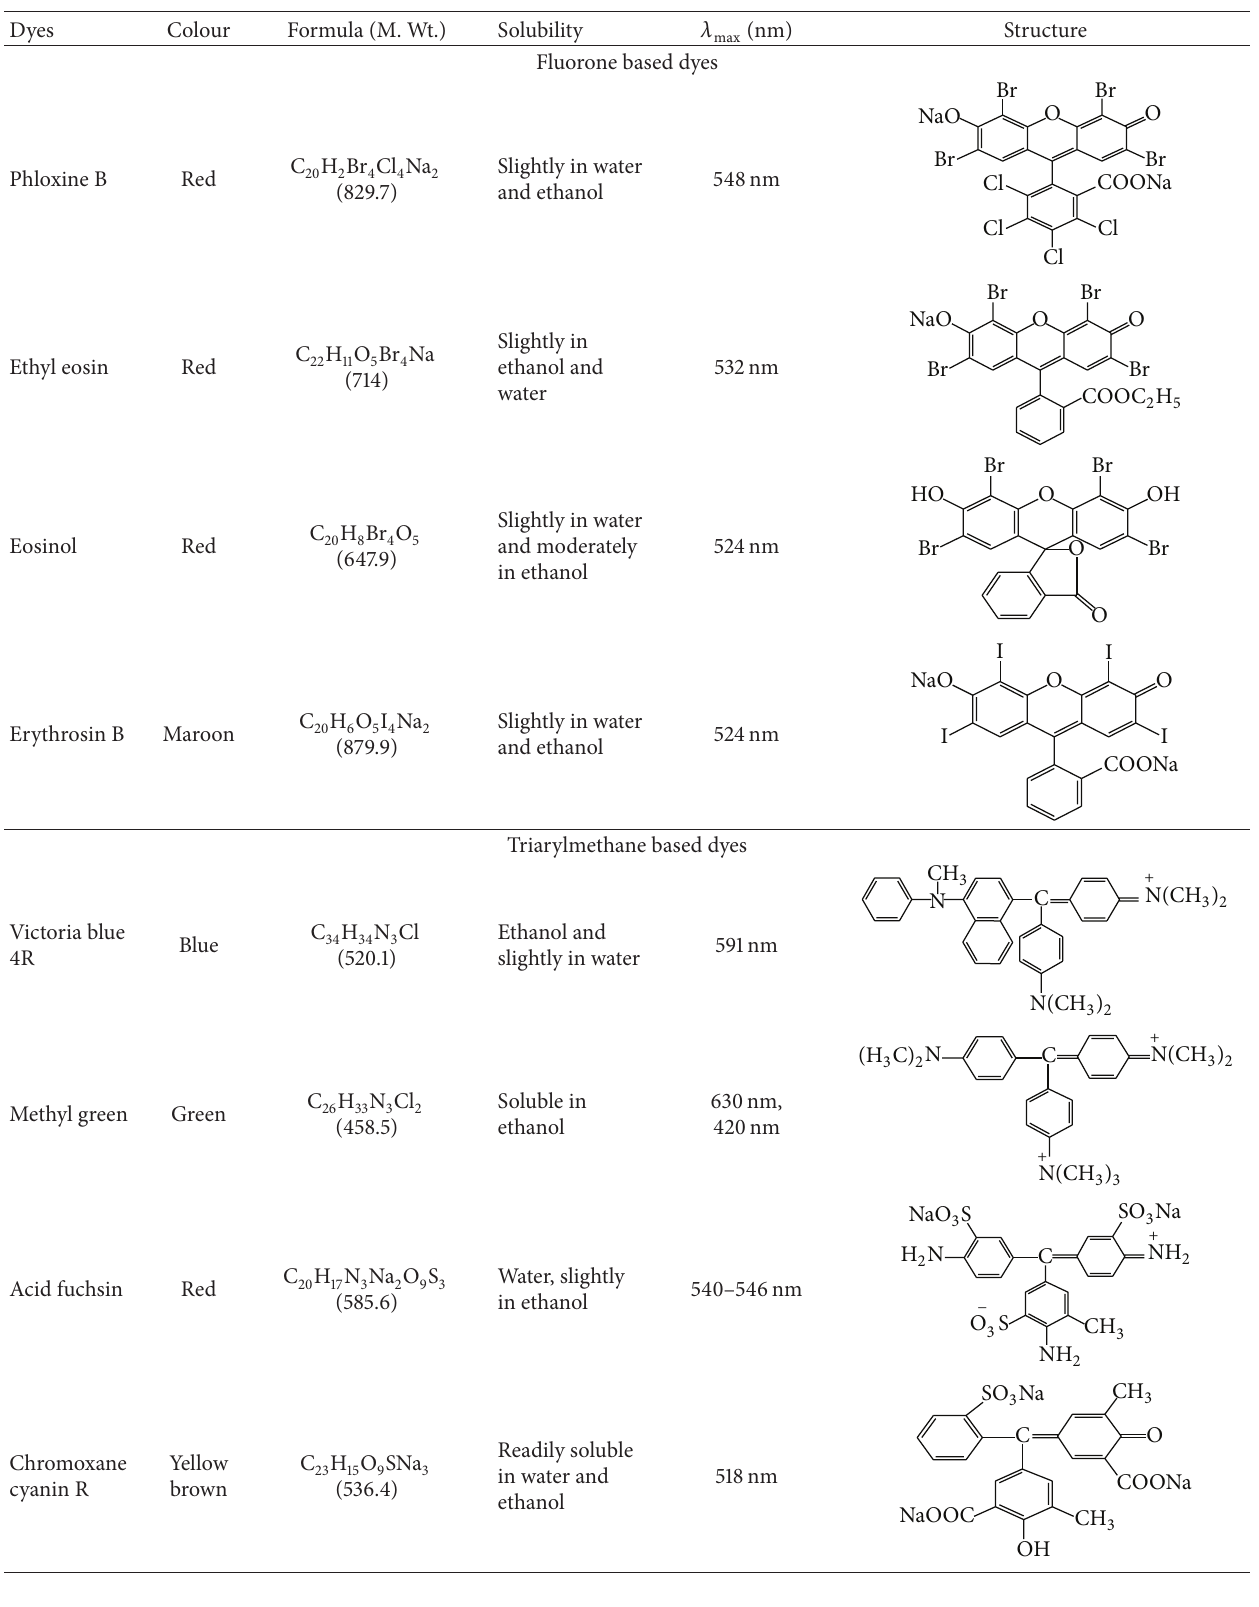
Table1:Molecularformula,colour,solubility, 𝜆 max value,andstructureoffluorone,triarylmethane,azo,andthiazinebasedmetal-freeorganic